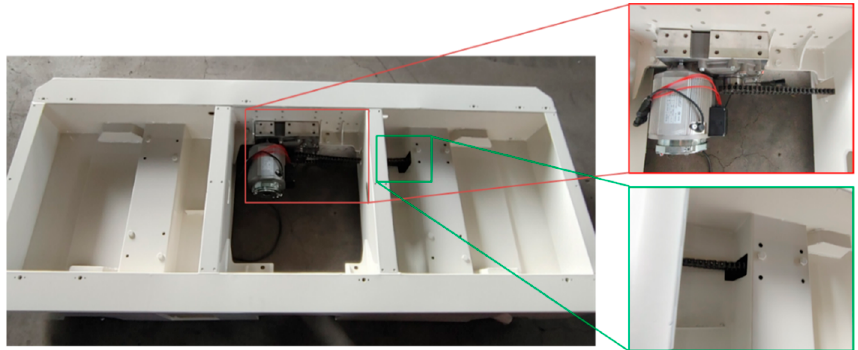
Figure 4. Rail wheel drive using chain belt type.